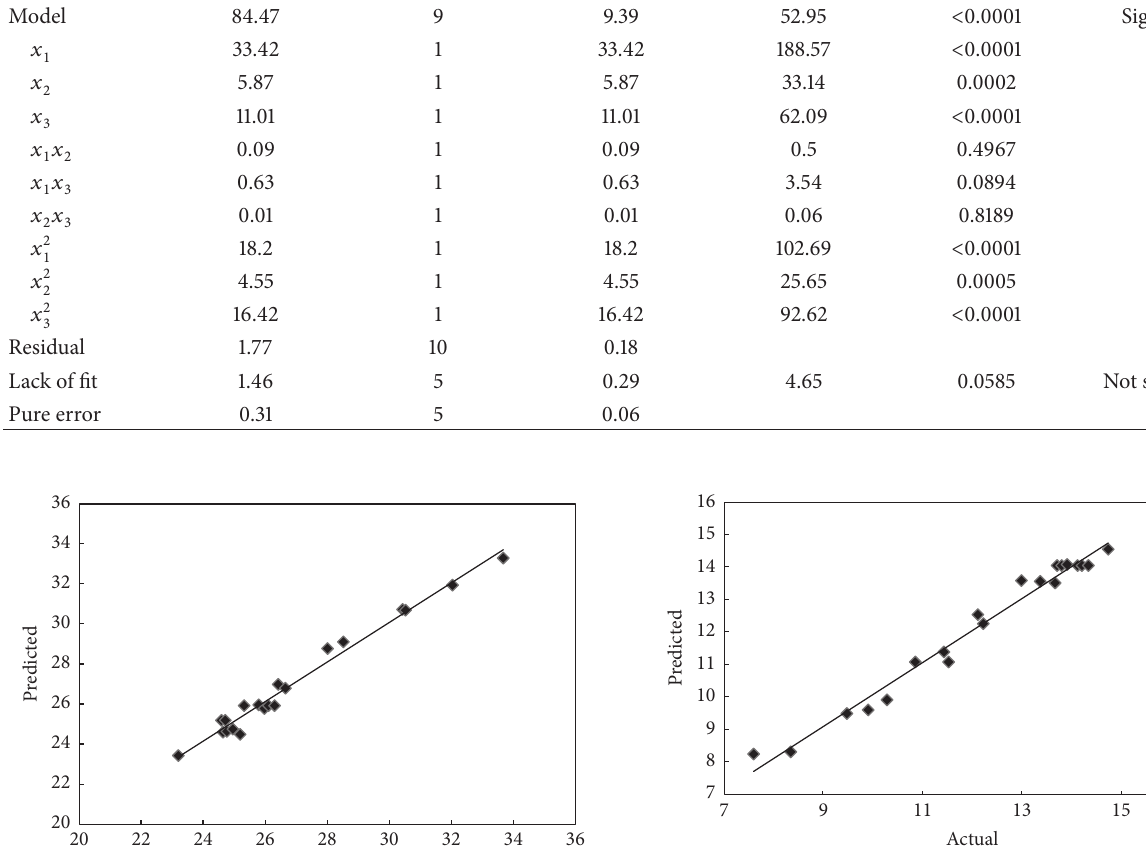
Table 4: Analysis of variance (ANOVA) for response surface quadratic model for adsorption capacity of OPEFB biochar. Source of data